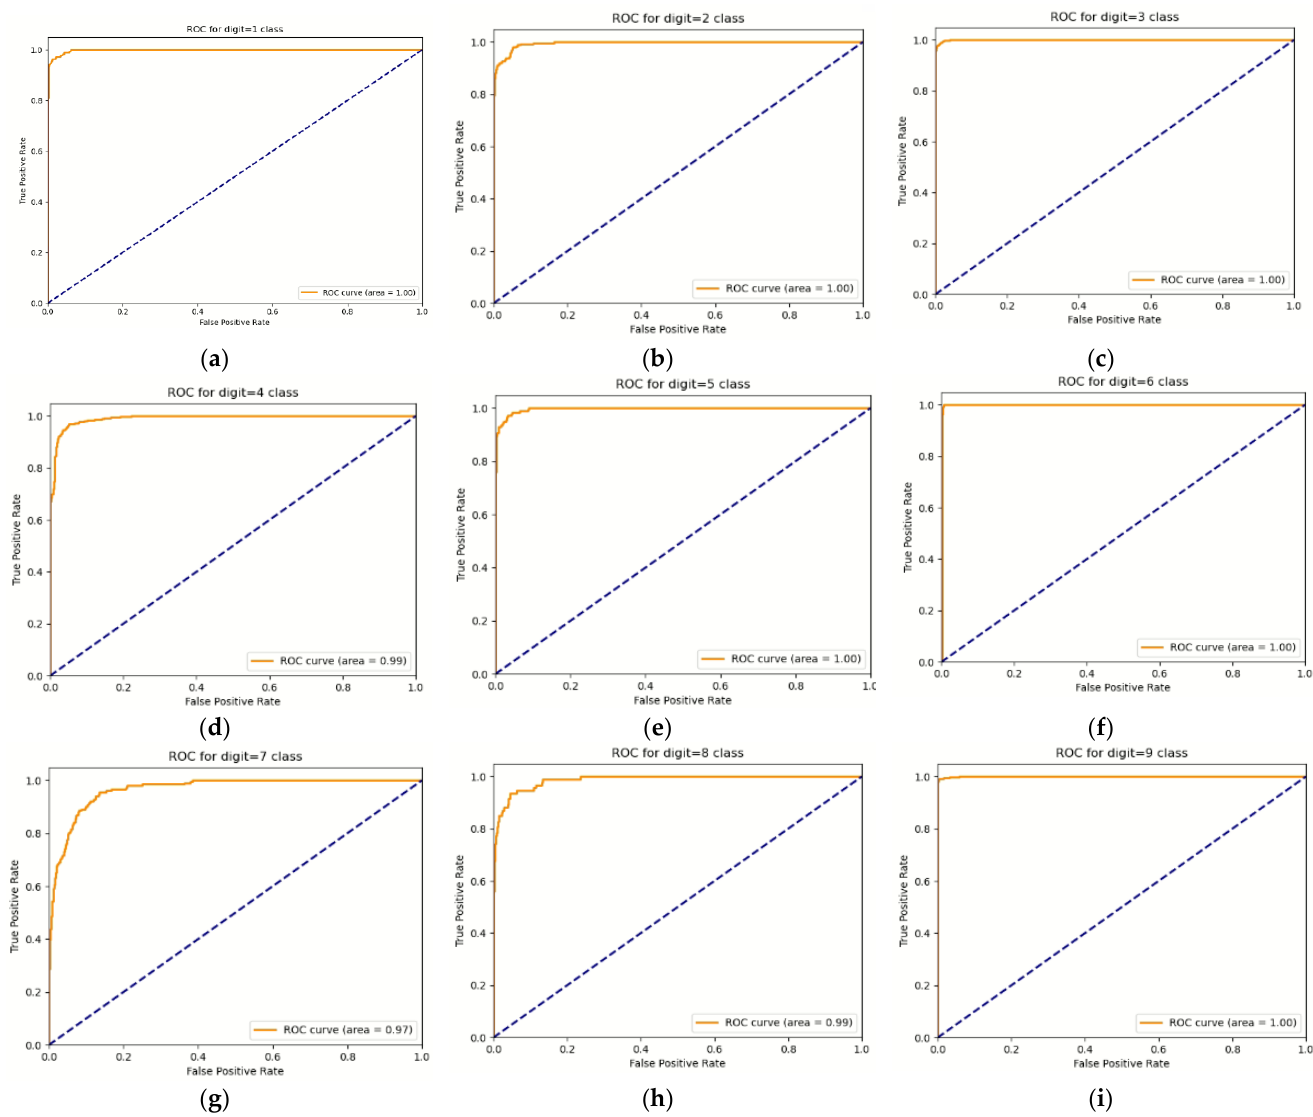
Figure 10. ROC curve and AUC value for each activity class. ( a ) A01 class, ( b ) A02 class, ( c ) A03 class, ( d ) A04 class, ( e ) A05 class, ( f ) A06 class, ( g ) A07 class, ( h ) A08 class, ( i ) A09 class.